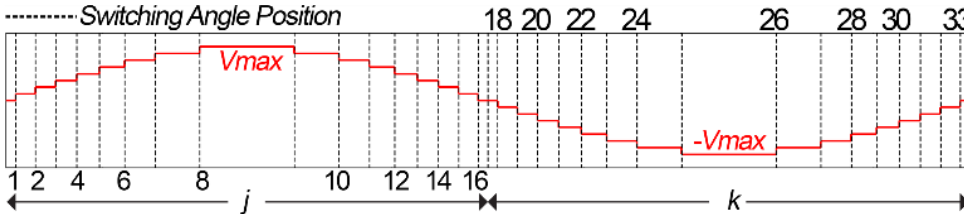
Figure 6. Switching angle